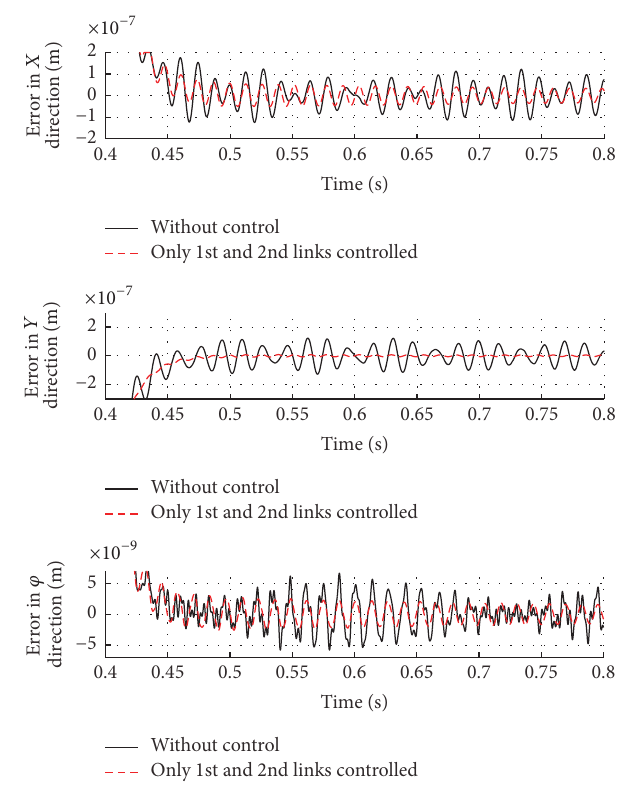
Figure 10: The positioning error of the rigid motion under the third case.